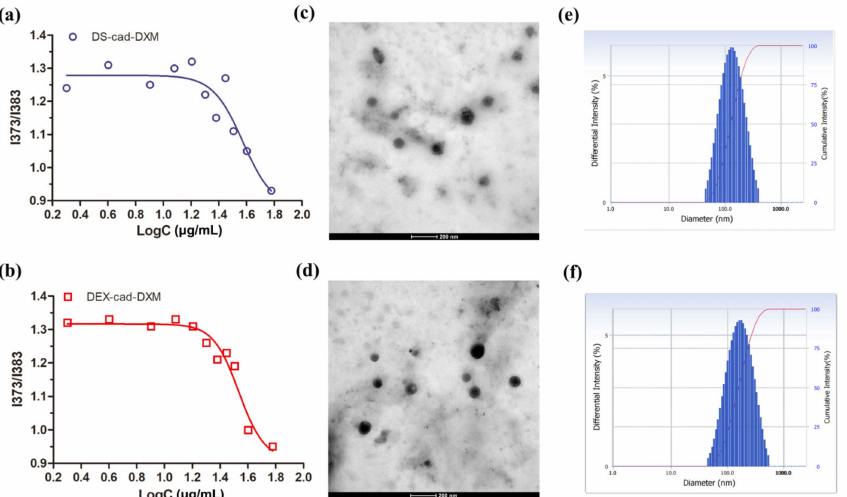
Figure 2. CMC value of DEX-cad-DXM ( a ) and DS-cad-DXM ( b ) conjugates. TEM image of DXM@DS- cad-DXM micelles ( c ) and DXM@DEX-cad-DXM micelles ( d ). Size distribution of DXM@DS-cad-DXM